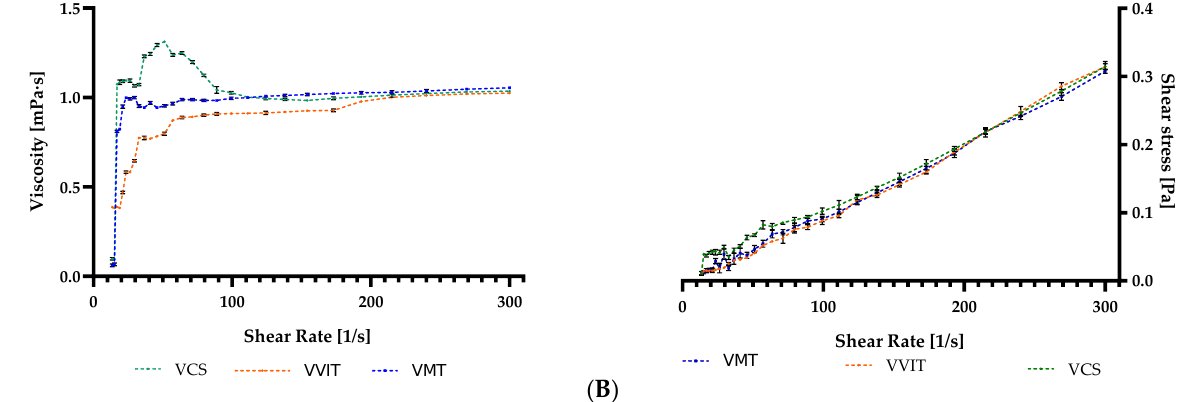
Figure 1. The ( A ) viscosity and ( B ) shear stress of aqueous solutions with the increase of shear rate, Abbreviations used: VMT ( V. myrtillus L.), VCS ( V. corymbosum L.), and VVIT ( V. vitis-idaea L.)—plant species; Values (expressed as mean values ± SD, n = 3).